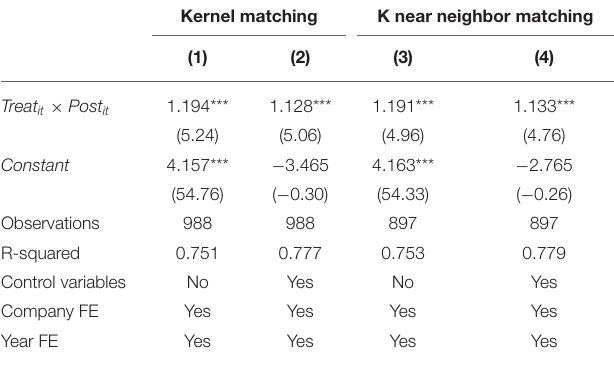
TABLE 5 | Regression results of PSM-DID.